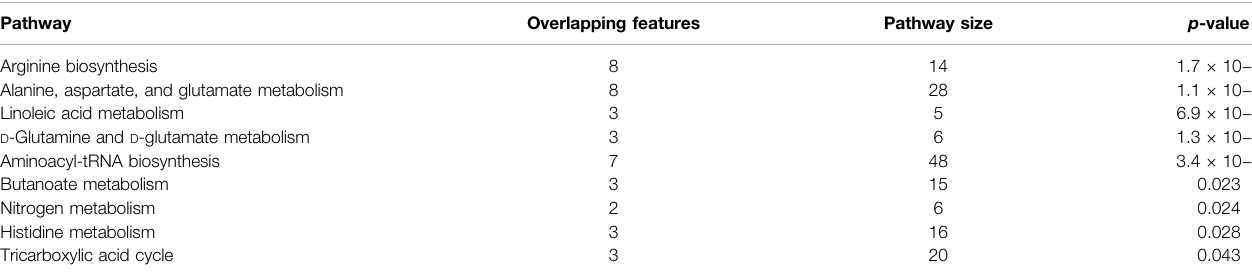
TABLE 3 | KEGG enrichment pathways altered in PDR patients compared with T2DM patients.